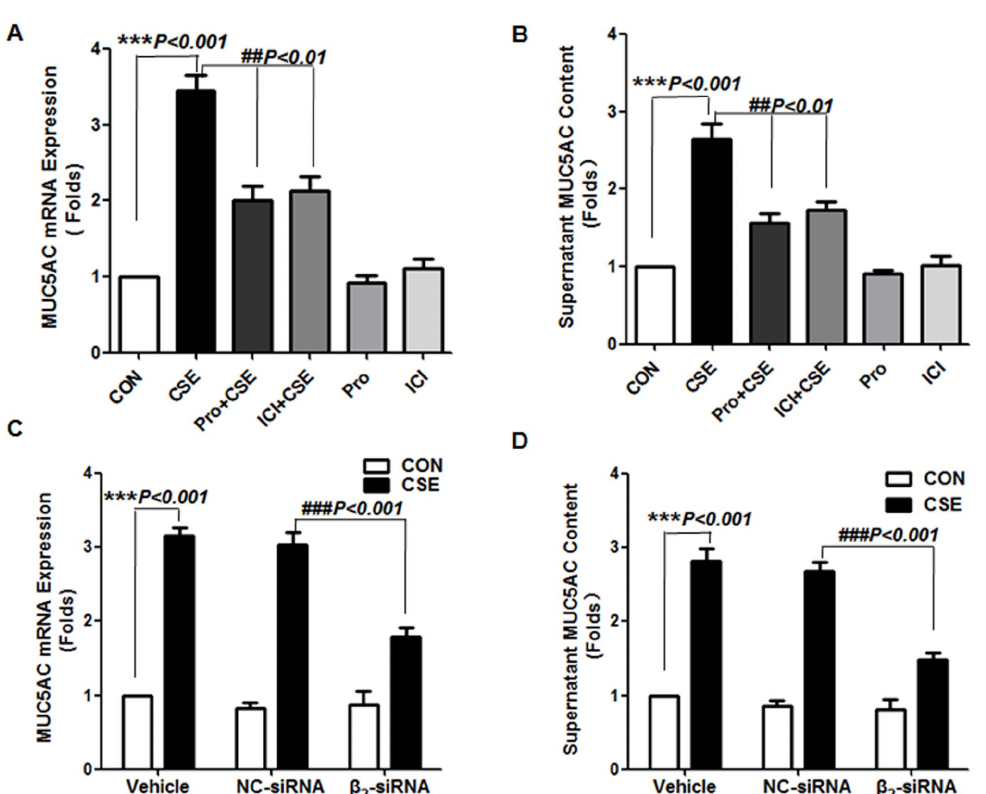
Figure 2. b 2 -AR blockade attenuates cigarette smoke extract (CSE)-induced MUC5AC production from NCI-H292 cells. Cells were pre- incubated with 10 2 5 M propranolol or 10 2 6 M ICI118551 for 30 min before adding CSE (Pro + CSE, ICI + CSE) or were incubated with media (CON), CSE, 10 2 5 M propranolol (Pro), or 10 2 6 M ICI118551 (ICI) alone for 24 h. Quantitative RT-PCR and ELISA of MUC5AC mRNA (A) and protein level (B), respectively, and MUC5AC mRNA (C) and protein secretion (D) of cells transfected with Lipofectamine2000 (vehicle), a nonspecific control siRNA (NC- siRNA, 100 nM) or b 2 -AR–targeted siRNA ( b 2 -siRNA, 100 nM) for 48 h before incubation with or without CSE for 24 h. Data are means 6 SEM (n=3). doi:10.1371/journal.pone.0097788.g002 PLOS ONE |